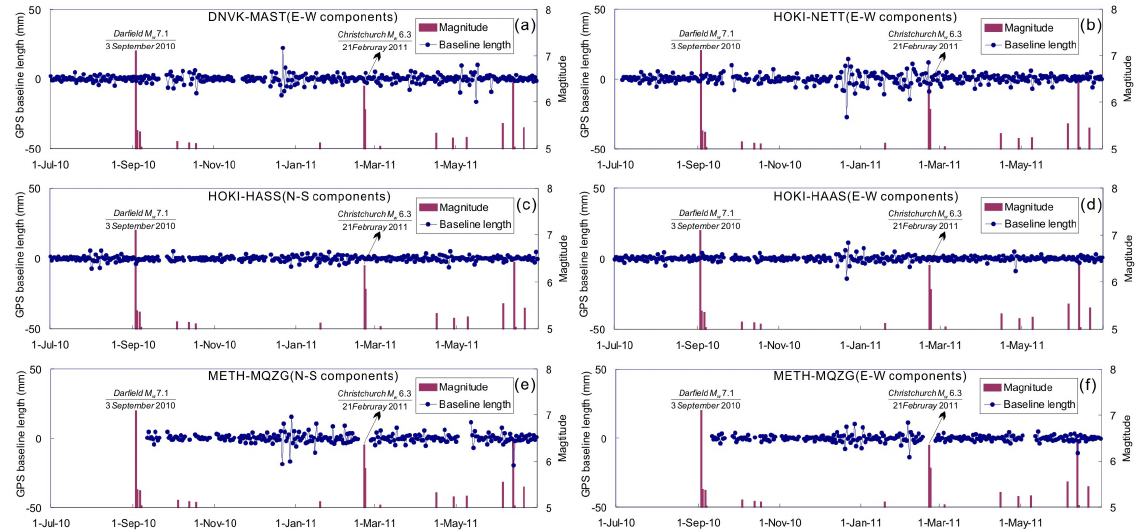
Fig. 7. GPS baseline-lengths change between stations. The brown columns indicate the mainshock and aftershocks ( M > 5). (a) shows the E–W components of DNVK-MAST baseline-lengths elongated obviously on 22 December 2010, which likely reflected the subduction- caused uplift action in the south of the North Island. (b) shows the E–W components of HOKI-NETT shortened obviously on 22 De- cember 2010; the N–S components of HOKI-HAAS elongated mildly on 31 July and 8 August 2010, and shortened mildly on 1 and 7 August 2010; the E–W components of HOKI-HAAS shortened obviously on 21 December 2010 and elongated obviously on 22 Decem- ber 2010, which likely reflected the strike-slip motion in the two sides of Alpine Fault. (c) shows the N–S components of METH-MQZG shortened obviously on 21 and 27 December 2010 and elongated mildly on 28 December 2010, and the E–W components of METH-MQZG elongated obviously on 27 December 2010 and 5 February 2011 and shortened obviously on 6 February 2011, which likely reflected the dextral strike slip motion in the Canterbury